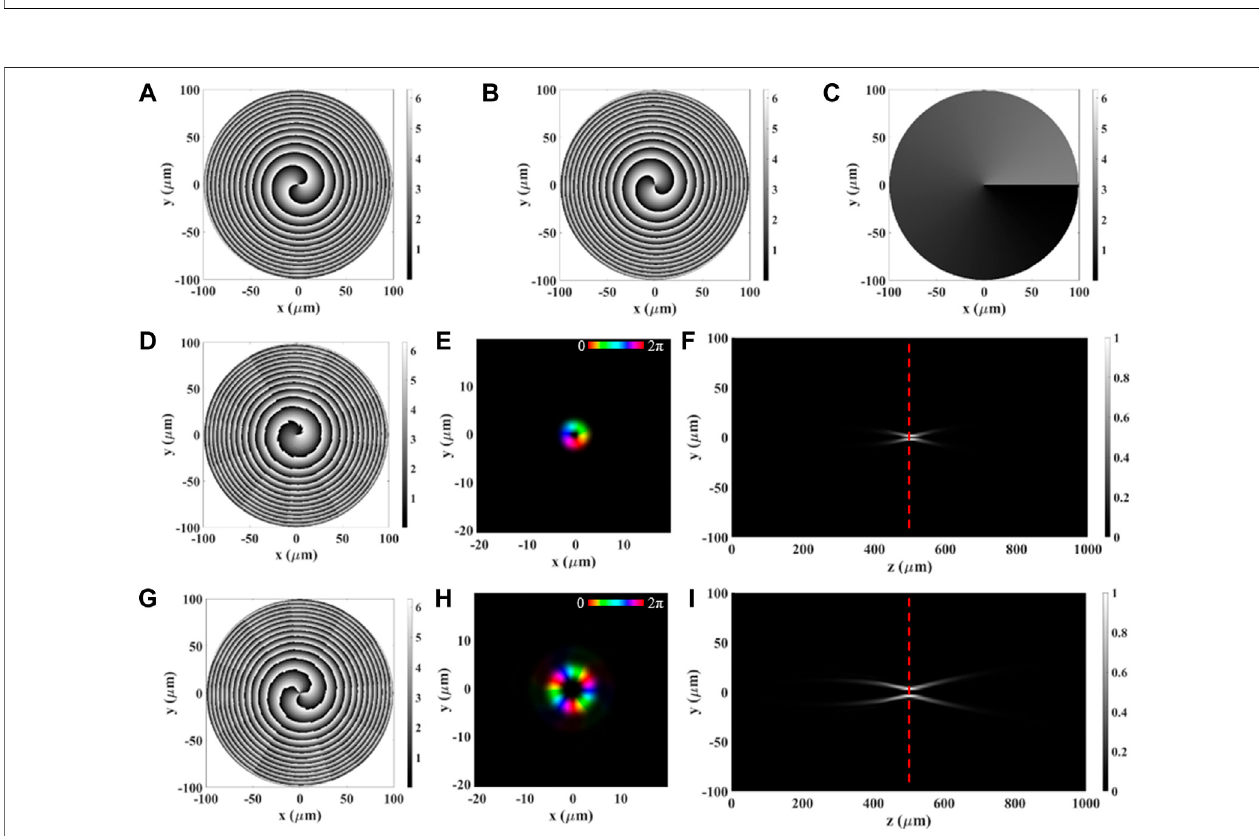
FIGURE 4 | Simulations of DFML implementing Eqs 14 , 15 . (A – C) ML design phase maps of δ x (A) , δ y (B) , and θ (C) from Eqs 7 – 9 . (D,G) show ϕ + and ϕ − phase maps,respectively. (E) Intensityandphaseofthepropagated fi eldunderLCPpolarizationat z =500 µm. (F) Intensitycross-section( yz -plane,from0to1 mm,x =0)under LCP polarization. (H) Intensity and phase of the propagated fi eld under RCP polarization at z = 500 µm. (I) Intensity cross-section ( yz -plane from 0 to 1 mm, x = 0) under RCP polarization. In (E,H) , brightness and colours refer to intensity and phase, respectively.